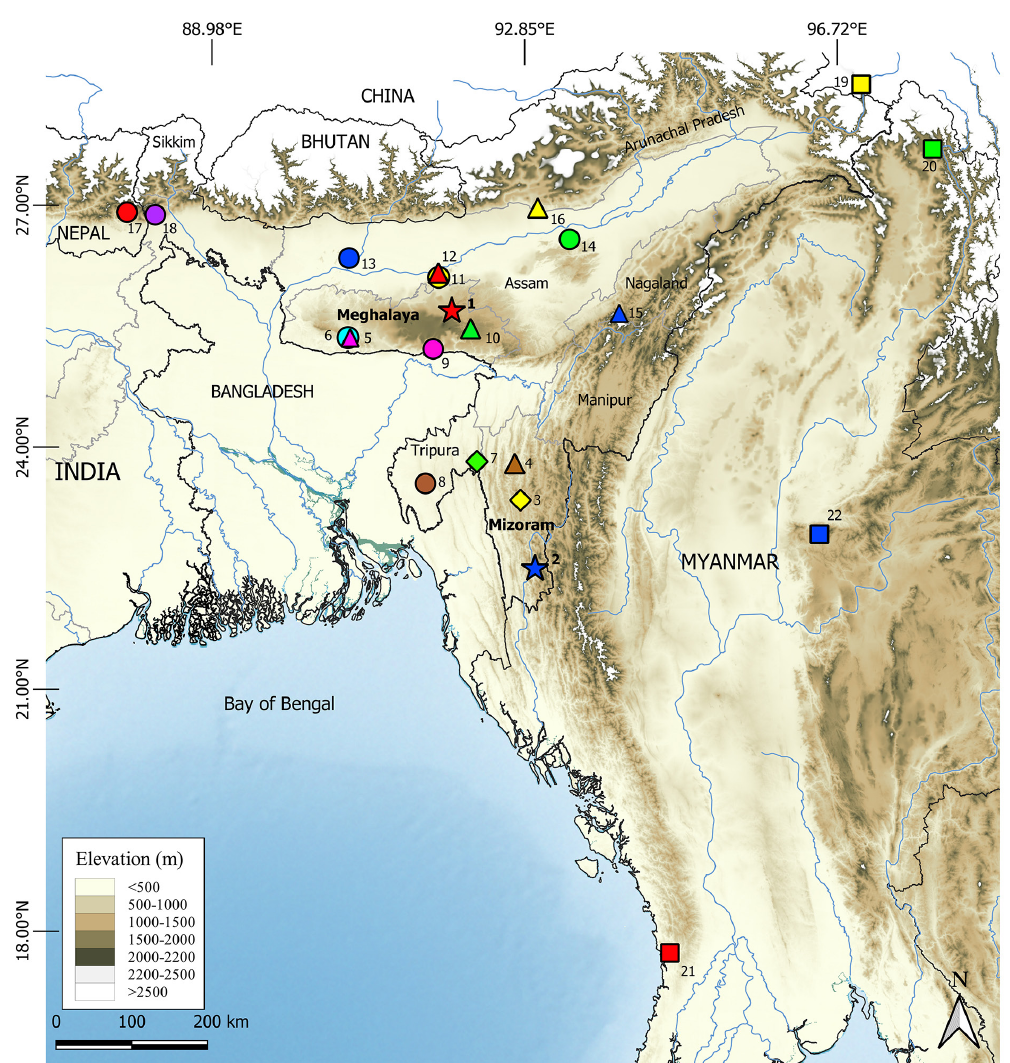
Fig. 1. Elevation map showing the type localities for the two newly described species of Cyrtodactylus and the congeners compared in this paper: 1 . Cyrtodactylus exercitus sp. nov. (red star). 2 . C. siahaensis sp.